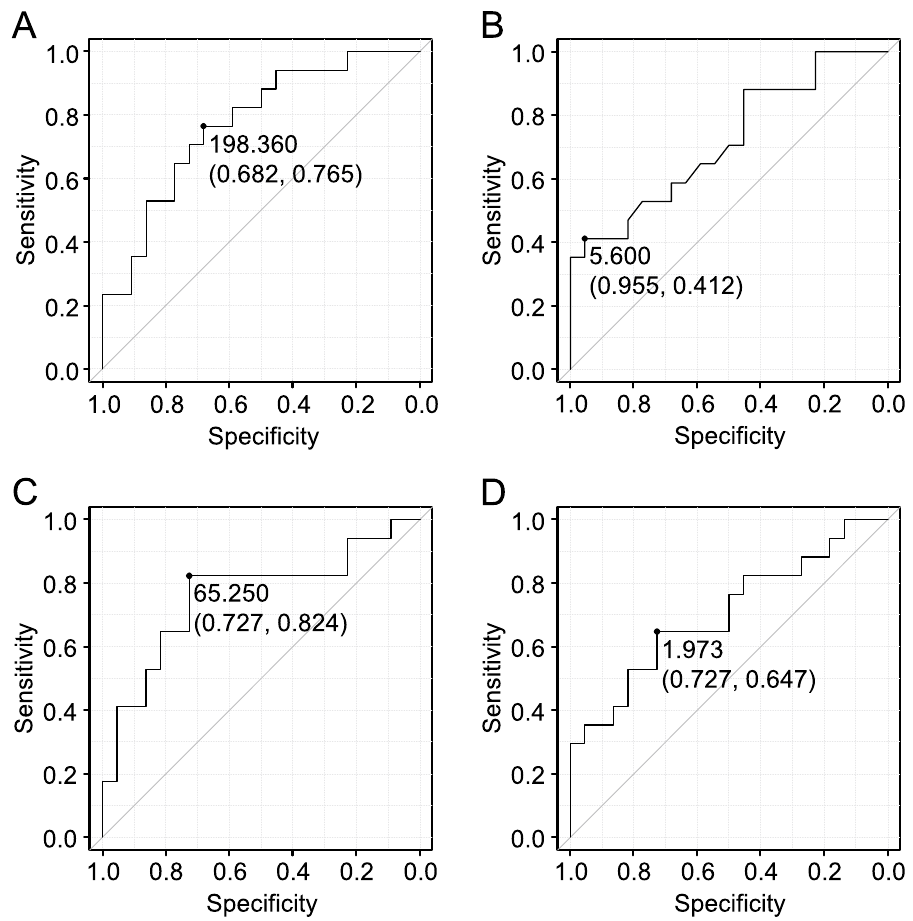
Figure 3. Receiver operating characteristic curves for determination of the cut-off values of the eosinophil counts to predict AI. ( A ) Absolute eosinophil counts, ( B ) relative eosinophil counts, ( C ) difference in absolute eosinophil counts between the baseline and at pre-onset, and ( D ) rate of increase in eosinophil counts between the baseline and at